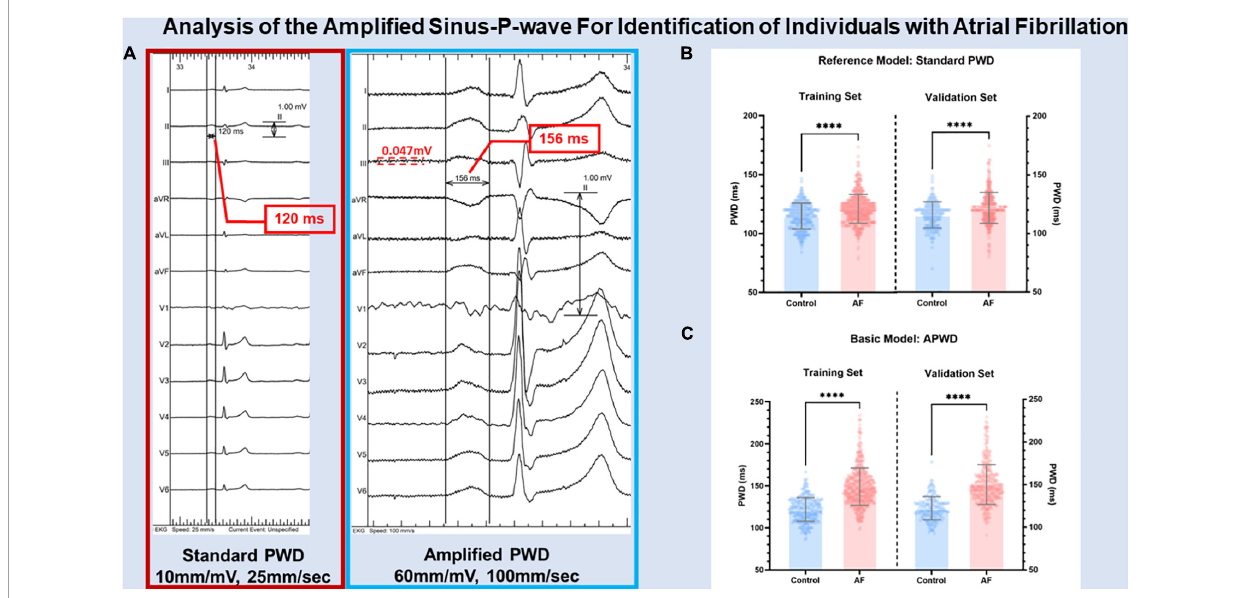
FIGURE2 Illustration of PWD measurement in standard and amplified scaling. Panel (A) illustrates the results of p-wave duration from the same digital 12-lead ECG measured at standard scaling (10 mm/mV, 25 mm/s) and amplified scaling (60 mm/mV, 100 mm/s) using digital calipers. PWD was measured from the earliest p-wave onset until latest p-wave ending in any of the 12 leads at respective scaling. The noise level of annotated by the red dashed lines. Panel (B,C) illustrate the difference between control and AF cohorts in internal and external validation using standard PWD (reference model) and APWD (basic model), respectively. PWD, p-wave duration; standard PWD, duration of standard p-wave; APWD, duration of amplified p-wave; ∗∗∗∗ p < 0.001.